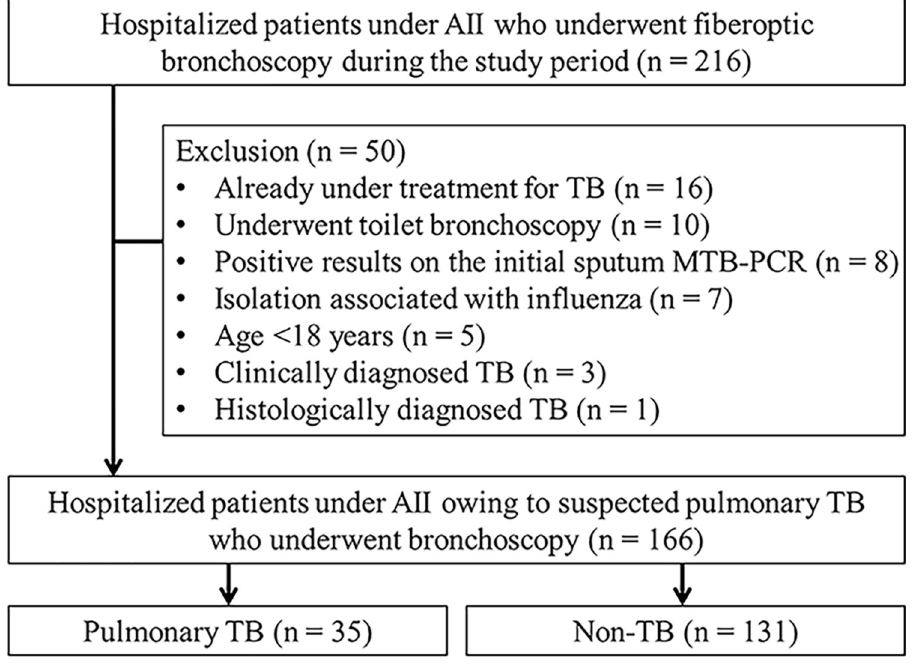
Fig 1. Flowchart of study inclusion. AII, airborne infection isolation; MTB, Mycobacterium tuberculosis ; PCR, polymerase chain reaction.